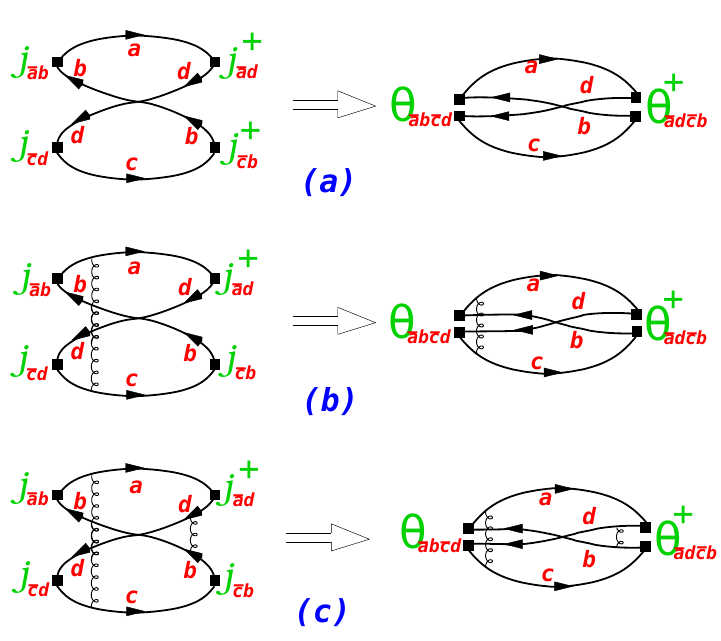
Figure 6. Flavour- redistributing correlation function [6, 7]: illustrative examples of contributions of the three (a,b,c) lowest perturbative orders and their contractions to two tetraquark-interpolating operators θ